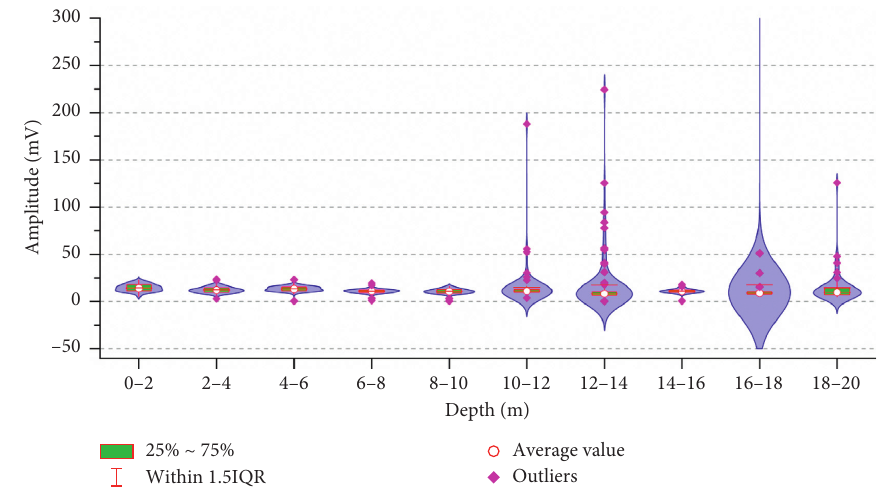
Figure 8: Distribution statistics of amplitude values in each amplitude